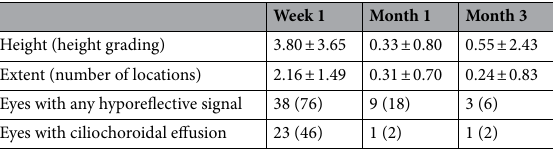
Table 1. Hyporeflective supraciliary change. Data present in mean ± standard deviation and N (%).